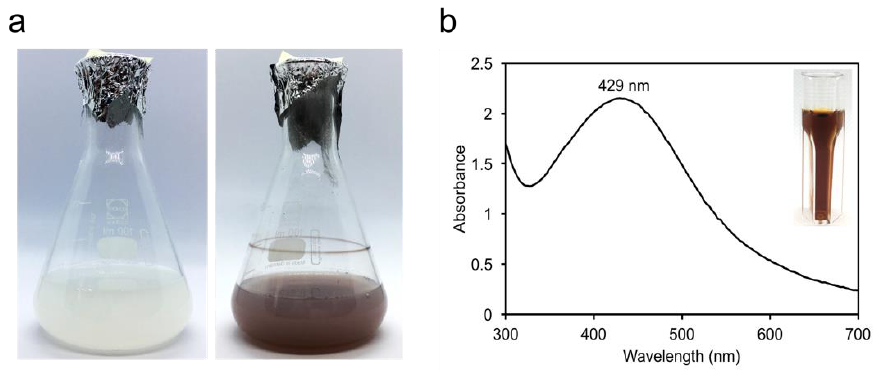
Figure 3. ( a ) Visual observation of AgNPs formation by cell biomass of L. plantarum TA4. ( b ) UV–Visible absorption spectra of biosynthesized AgNPs. The inset image shows the visual observation of biosynthesized AgNPs.